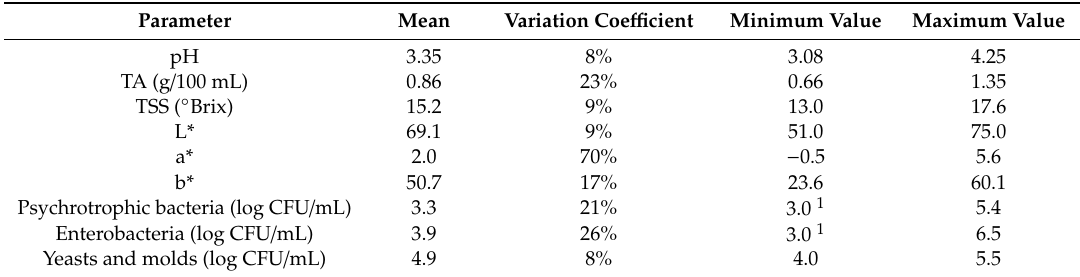
Table 2. Physicochemical and microbiological characteristics of untreated pineapple juice on the day of preparation.